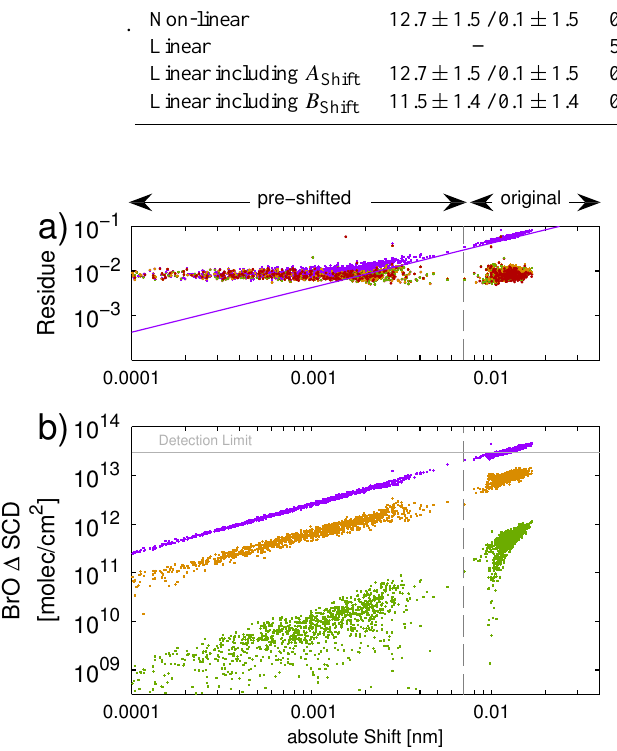
Fig. 8. Dependency of the fit residues (a) and the absolute BrO SCD bias with respect to the non-linear fit (b) on the absolute spectral shift. Colours as in Fig. 5. The purple line corresponds to Eq. (9) for a = 0 . 7 and ς = 0 . 2nm. Results from the original and the pre- shifted set of references are